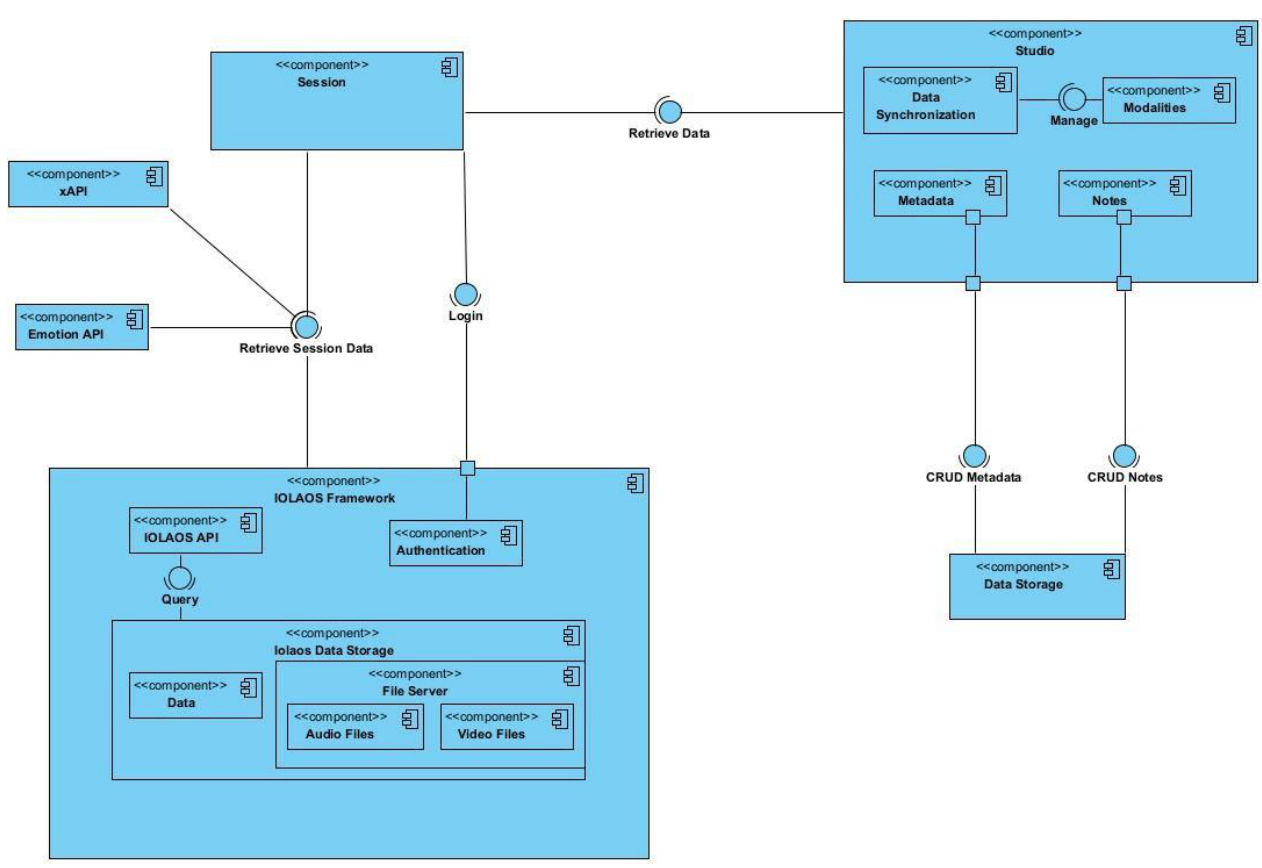
Figure 2. ARION Component Diagram.